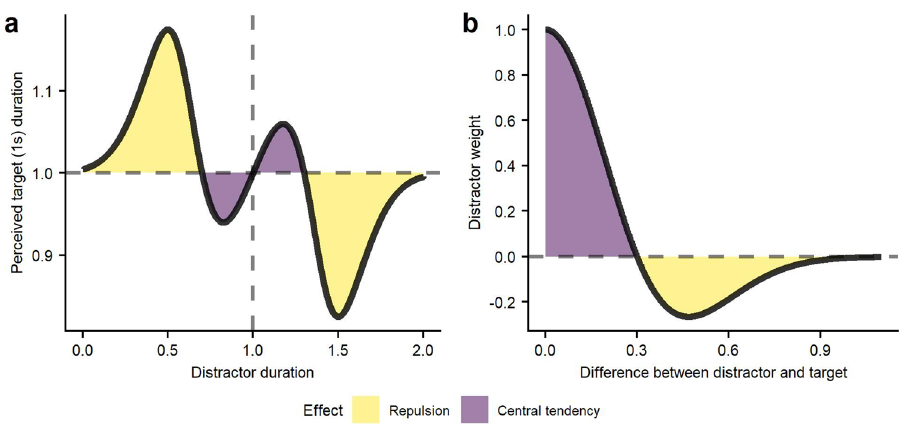
Figure 7. Example of the advanced model with a k of 0.3. ( a ) Perceived duration of a 1 s target as a function of the duration of simultaneous distractors. ( b ) Weight of the distractors as a function of their difference with the target duration using a ricker wavelet. Colours represents the direction of the effect from distractors on the perceived target